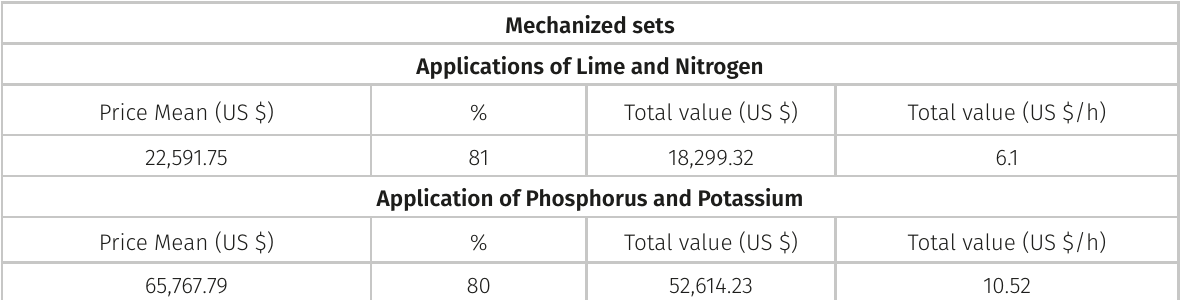
Table III. Maintenance.